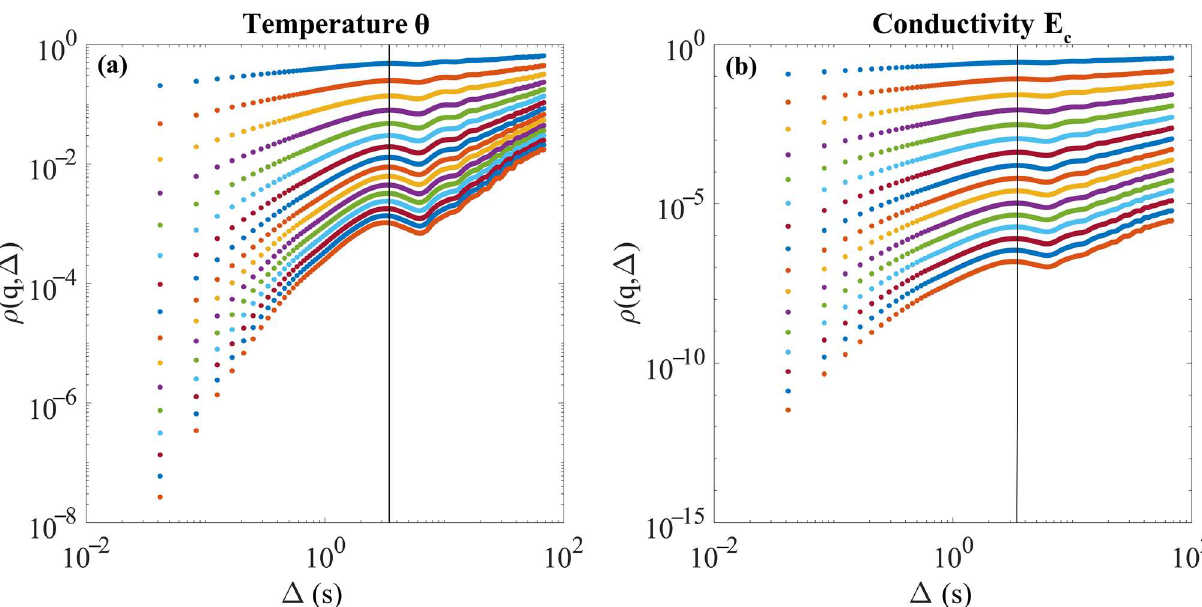
Figure 5. Generalised moments of CTD30 for ( a ) temperature, θ, and ( b ) conductivity, E c , as function of the lag time, Δ, for different moment orders, 𝑞 , ranging from 0.25 to 4 with steps of 0.25. The line represents the turning point where the convex shape of the short lag times ends. Notice that Δ (s) refers to the unit of time in seconds.